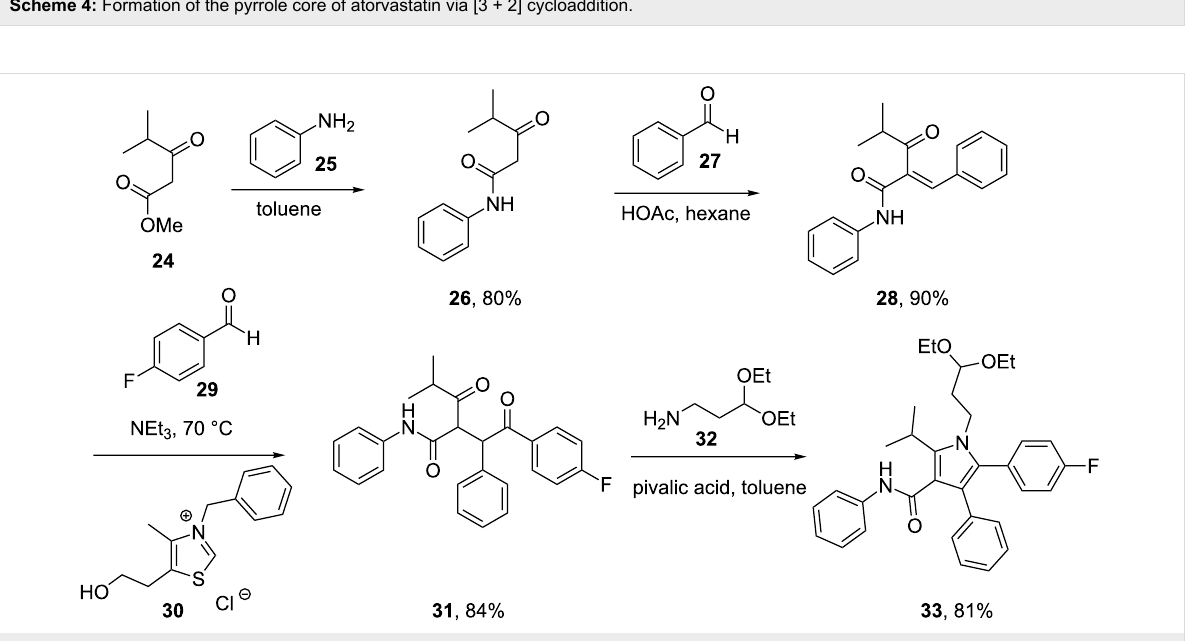
Scheme 5: Formation of pyrrole 33 via the Paal–Knorr